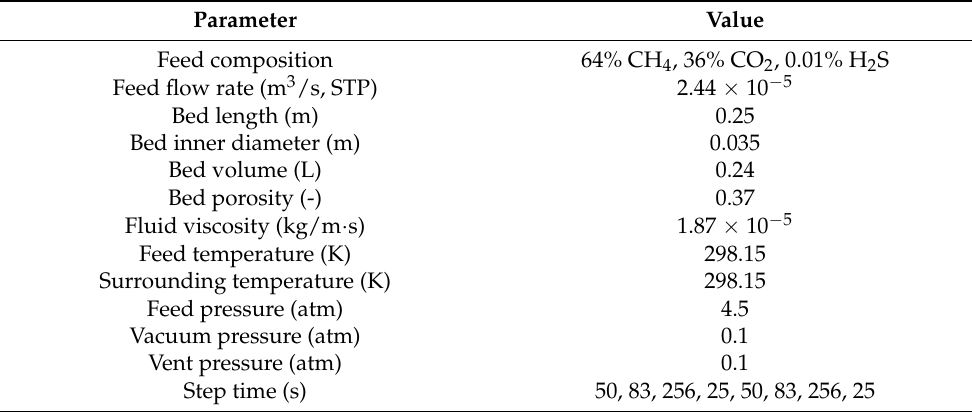
Table 17. Parameters of adsorption bed and operating conditions for the DOE optimal case.